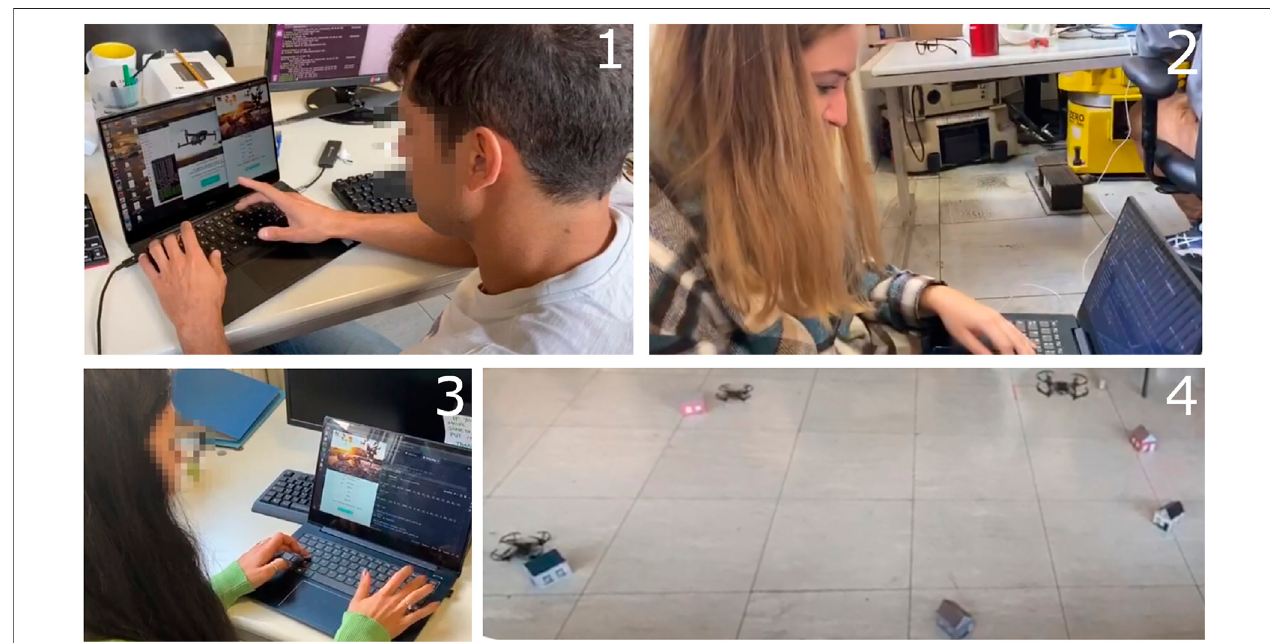
FIGURE5| 1:Residentvolunteerssubscribetothesystem.2:Civilprotectioninsertamission.3:Residentvolunteerscon fi rmtheiravailabilityforagiventimerange. 4: DJI Tello drones can take off.